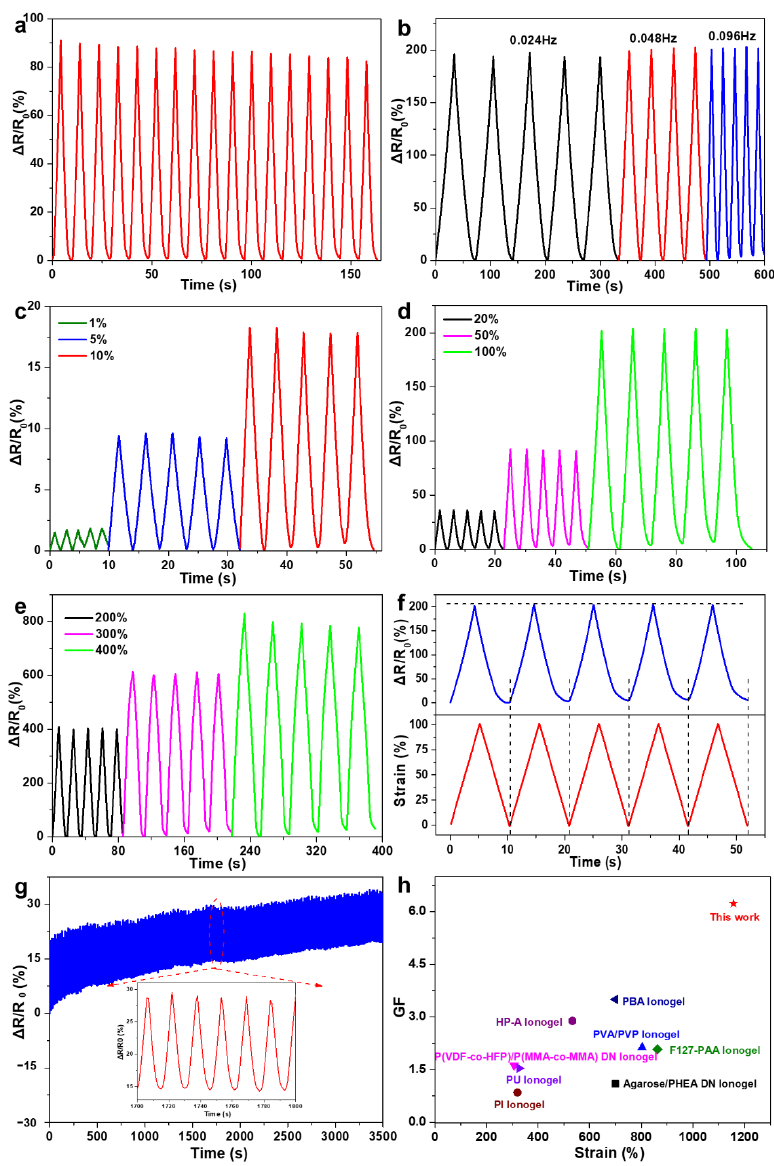
Figure 8. Sensing performance of the CS/PAA DN ionogel sensor: relative resistance change curve corresponding to 17 consecutive tensile cycles under a fixed strain of 50% ( a ); relative resistance change curve corresponding to different frequencies under a cyclic tensile strain of 100% ( b ); relative resistance change curve under different strain ( c – e ); the relationship between the input cyclic strain (100%) and the output signal of the relative resistance change ( f ); the relative resistance change curve corresponding to 200 continuous stretching cycles under a strain of 10% ( g ); the comparison of elon- gation strain and GF value of the reported ionogel flexible sensor ( h ): PI ionogel [50],